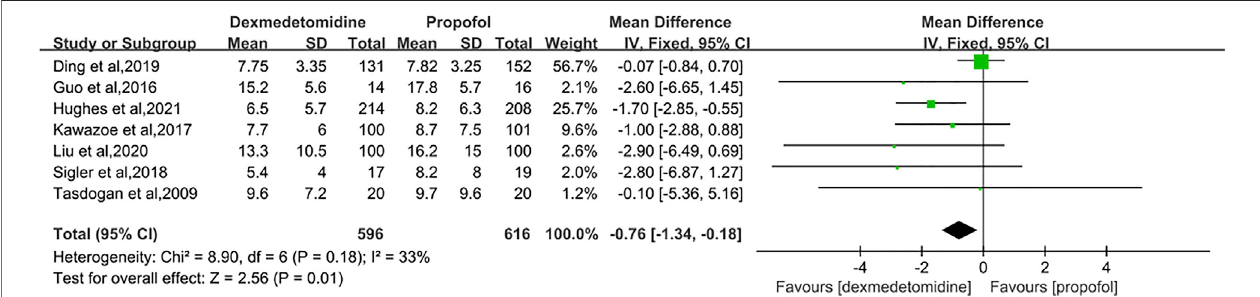
FIGURE 6 | Forest plot comparing the length of ICU stay between two groups.